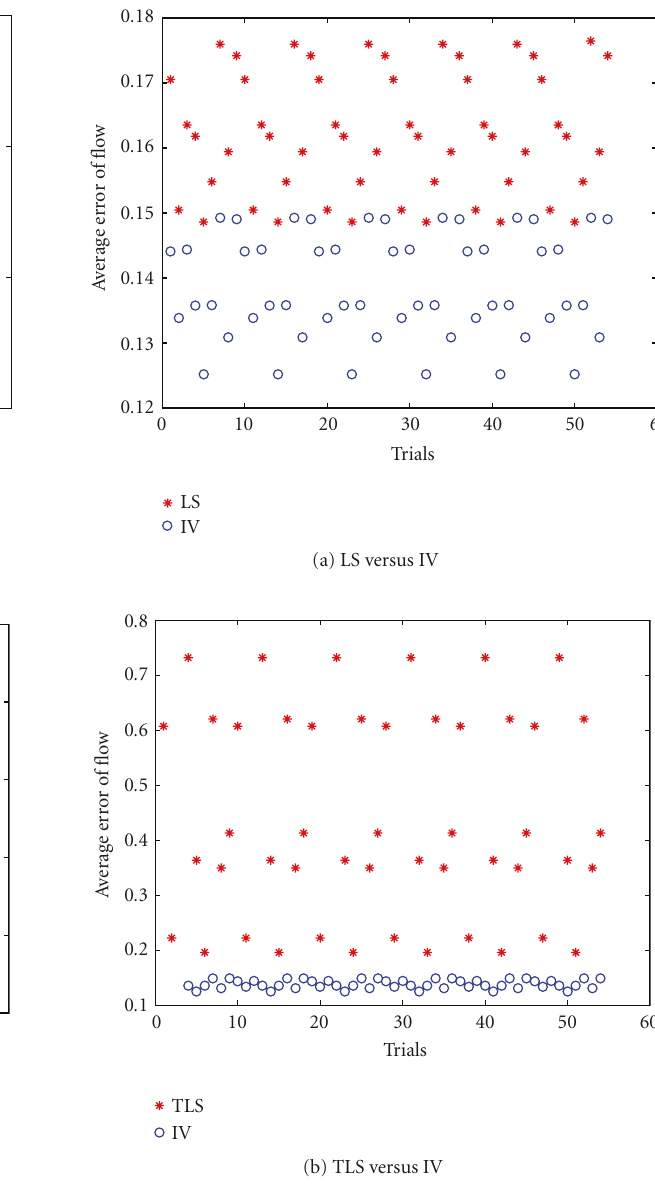
Figure 4: Performance comparison on the “o ffi ce” sequence. Figure 5: Performance comparison on the “cloud” sequence using the Lucas-Kanade three levels of resolution. The estimation was performed on the individual color channels (R, G, B) and on the combined color channels using LS, TLS, and the IV method. Figure 8(a) shows the average angular error between the estimated flow and the ground truth. Figure 8(b) shows the average relative error in the magnitude of the horizontal flow component, that is, denoting the ground truth of the magnitude of the flow values as x (cid:2) , the estimates as x i , and the confidence in i the estimates (the condition number of matrix A in the equa- tion Ax = b ) as con ( x i ), the error was found as the mean of ( | x (cid:2) − x i | /x i )con ( x i ). As can be seen, there is di ff erent in-